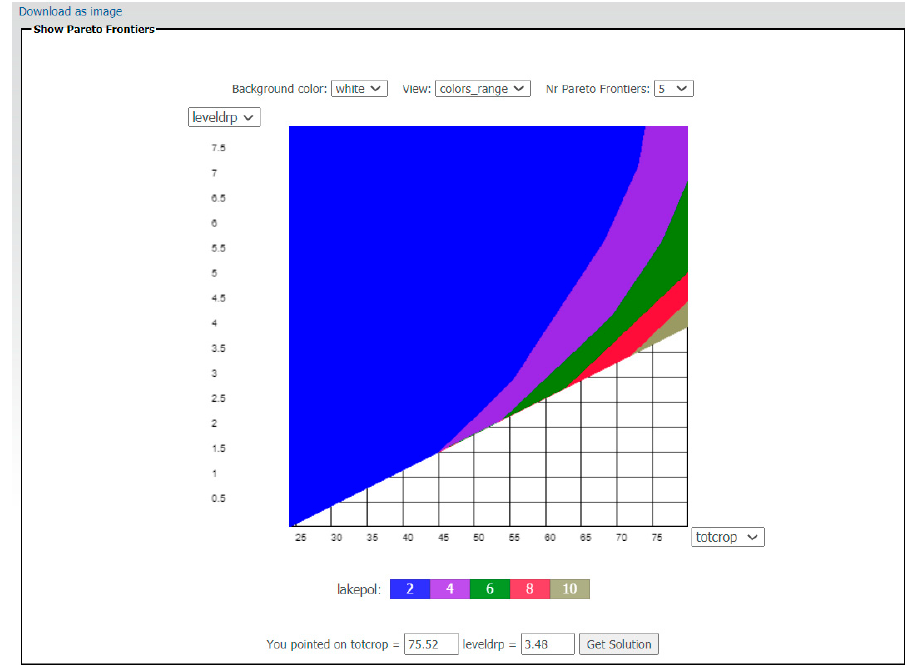
Figure 6. Representation of Pareto frontiers for the criteria totcrop (horizontal axis; in %), leveldrp (vertical axis; in %), and lakepol (represented by slices; in mg L − 1 ).